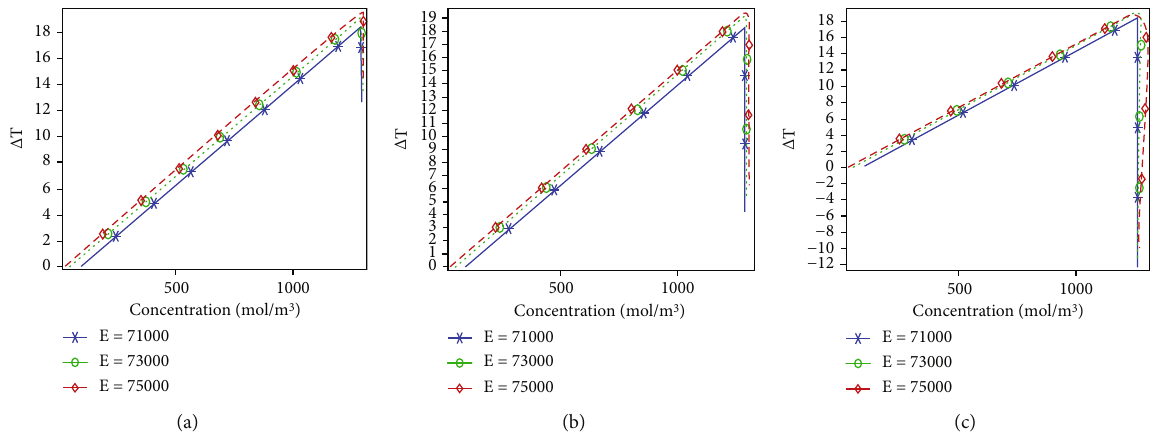
Figure 8: Change in the temperature at upstream along the backstep channel against the concentration of calcium hydroxide at (a) Re = 100 , I : C = 3 % , a = 0 : 5 ; (b) Re = 100 , I : C = 3 % , a = 0 : 6 ; and (c) Re = 100 , I : C = 3 % , a = 0 : 7 .